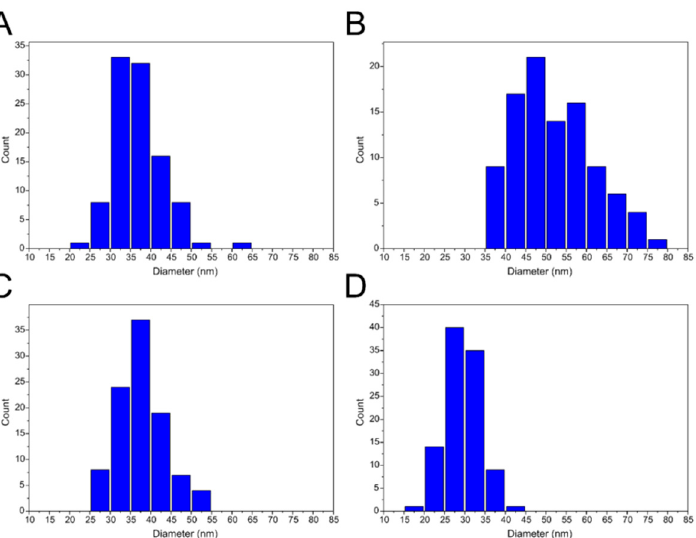
Figure 5. Size distribution of VLP populations from cryo-TEM images. ( A ) Empty VLPs obtained from wt CP (eVLPs). ( B ) Empty VLPs obtained from mutated CP (eMVLPs). ( C ) VLPs obtained from wt CP with tRNA (tVLPs). ( D ) VLPs obtained from mutated CP with tRNA (tMVLPs). The empty VLP analyses also involved atomic force microscopy (AFM). Experiments performed in air revealed that empty VLPs stably retained their spherical structure and dimensions in a dry environment (Figure 6). The average diameter of VLPs was 32 nm and ranged from 16 to 63 nm.